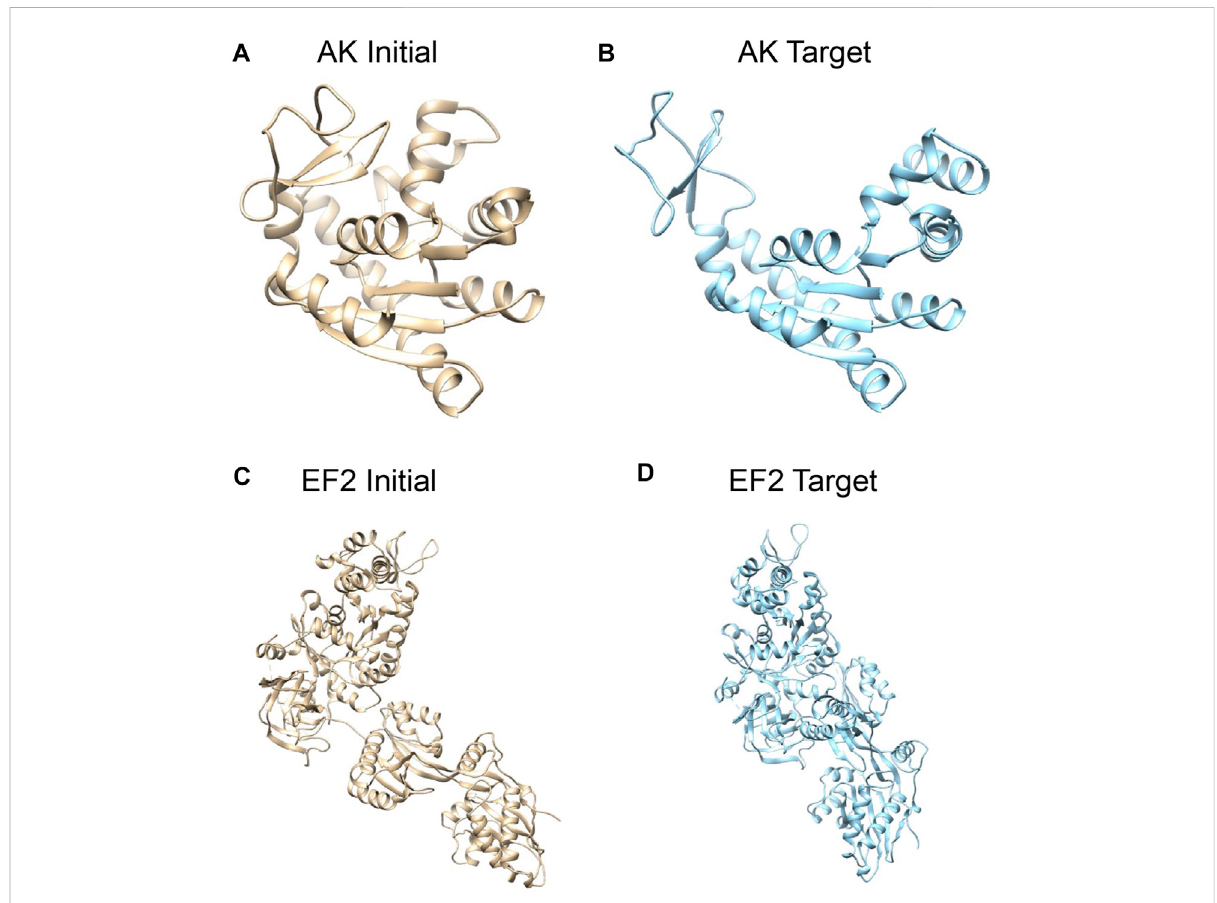
FIGURE 1 Systems studied: structures of adenylate kinase (AK); (A) the initial conformation (PDB: 1ake, chain A) (Whitford et al., 2007) and (B) the target conformation(4ake,chainA)(Mülleretal.,1996).Structuresofelongationfactor2(EF2); (C) theinitialconformation(1n0u,chainA)(Jørgensen etal., 2003) and (D) the target conformation (1n0v, chain C) (Jørgensen et al., 2003). The initial conformations are superposed to target conformations by Chimera (Pettersen et al.,